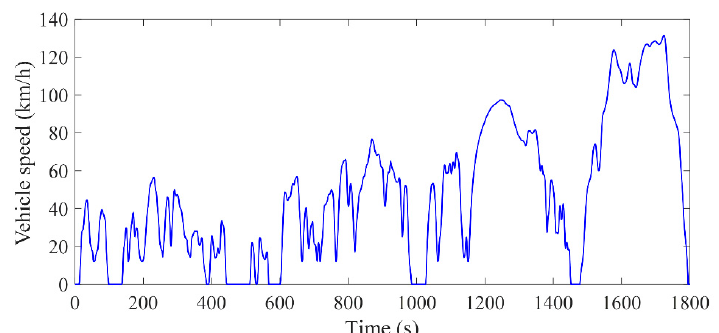
Figure 3. WLTP-3 driving cycle. Table 1 . Parameters of the CEV.